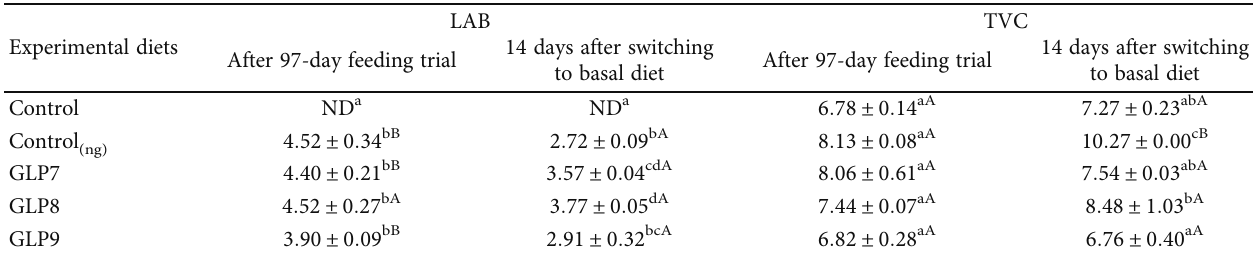
Table 5: Total viable heterotrophic aerobic bacteria (TVC) and autochthonous lactic acid bacteria (LAB) levels (Log CFU g -1 ) of narrow- clawed cray fi sh fed with di ff erent experimental diets after 97-day feeding trials and 14 days after switching to basal diets.